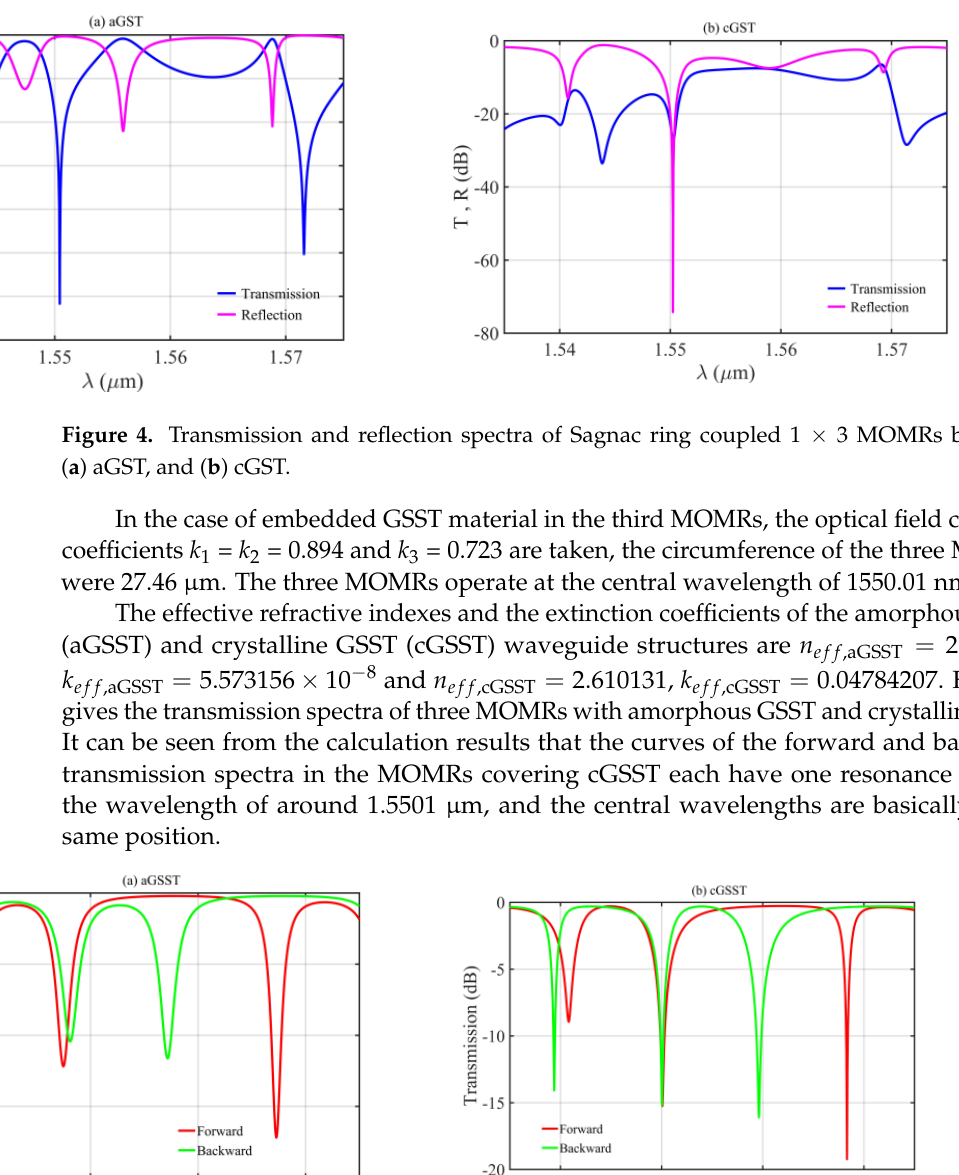
Figure 5. Transmission spectra of 1 × 3 MOMRs with ( a ) aGSST and ( b ) cGSST. The transmission and reflection spectra of Sagnac and three MOMRs structure with aGSST and cGSST were also calculated. As shown in Figure 6a, the transmittance of optical buffer covered aGSST has a peak value of − 59.05 dB near the wavelength of 1.5501 µ m (the blue curve), while in Figure 6b, the pink curve shows the reflectance of optical buffer covered crystalline GST has a peak value of − 70.14